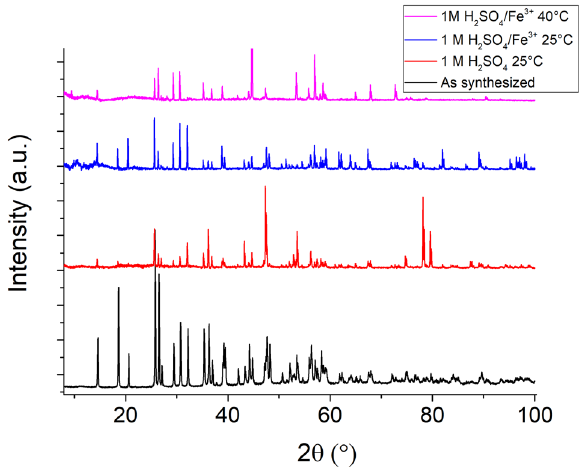
Fig. 2 Powder X-Ray Diffraction (PXRD) patterns of dissolved brannerite samples. PXRD patterns corresponding to the brannerite samples obtained after leaching experiments labeled 2, 5, and 11 (see Table